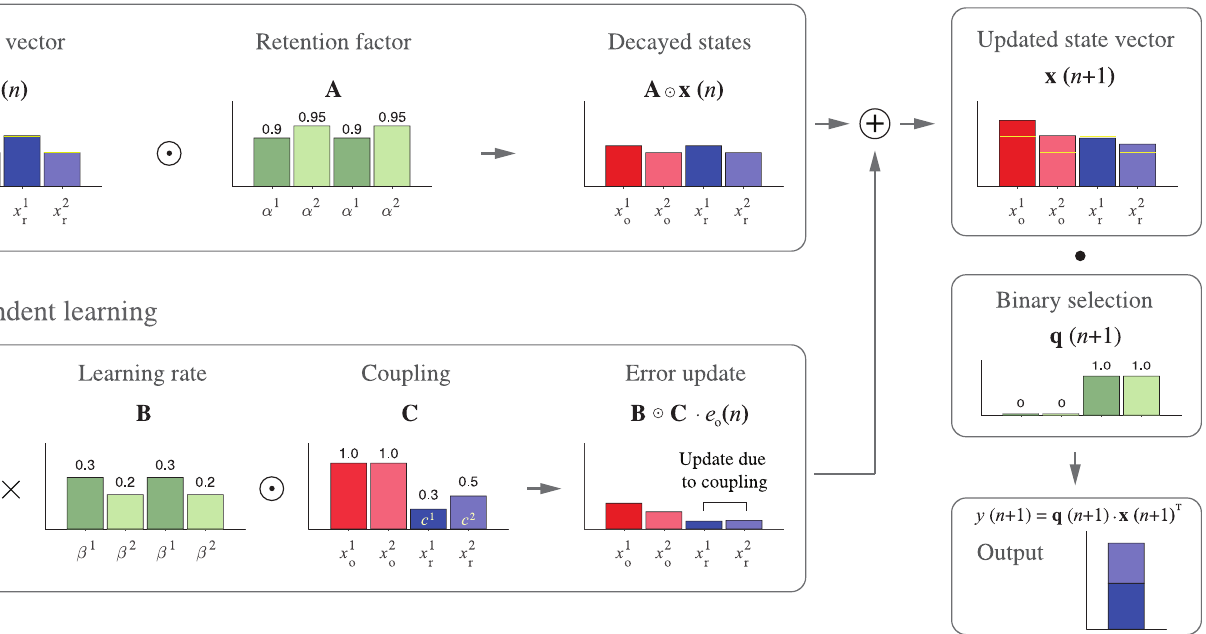
Fig 4. Model state update. A . The state update includes error-independent decay (top) and error-dependent learning (bottom). The four model states (top 1st plot) correspond to the two rates (superscripts, 1 and 2) and two movement directions (subscripts, o = Out and r = Return). The retention factor (top 2nd plot), which can be different for the two rates, determines the error-independent decay leading to decayed states (top 3rd plot). Error-dependent learning (bottom) is determined by the error experienced ( e o ( n ) for an Out trial, bottom 1st plot), the learning rate, which can be different for the two adaptation rates (bottom 2nd plot), and a coupling factor (bottom 3rd plot). The coupling factor is always 1 for the states (both rates) corresponding to the current movement, but can have non-zero and different values for the states corresponding to the reciprocal movement. The error update (bottom 4th plot) is the product of the error, the learning rate and the coupling factor. The updated state vector (top far right) is the sum of the decayed states and error update (yellow bar shows the previous state vector). Finally, the motor output (bottom right plot) is the sum of the states corresponding to the the given movement as determined by the binary selection